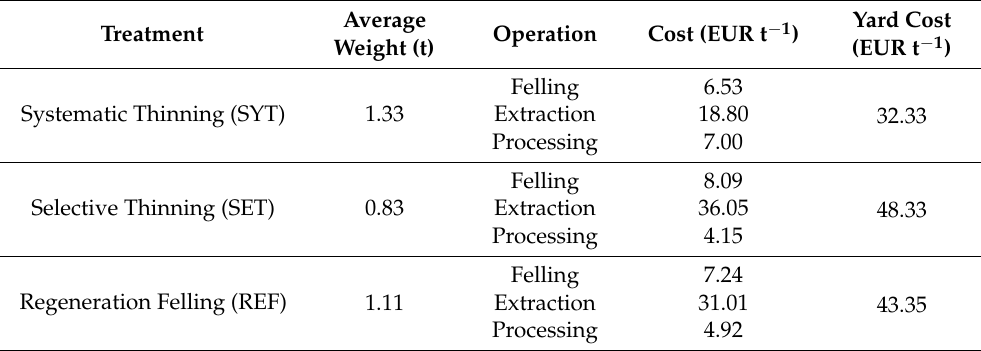
Table 4. Cost per ton calculated by applying the estimation models in relation to the average weight of the tree processed in the three treatments.